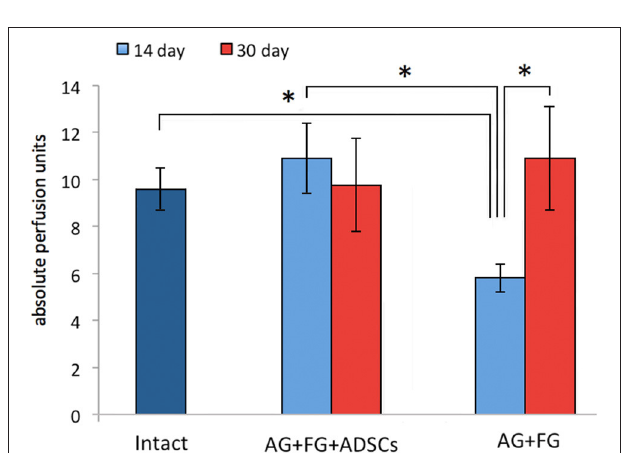
FIGURE 6 | Indicators of vascularization of the distal stump of the sciatic nerve at 14 and 30 days after AG. Differences were statistically significant between the groups *, between experimental groups (* P < 0.05, one-way ANOVA, Tukey’s